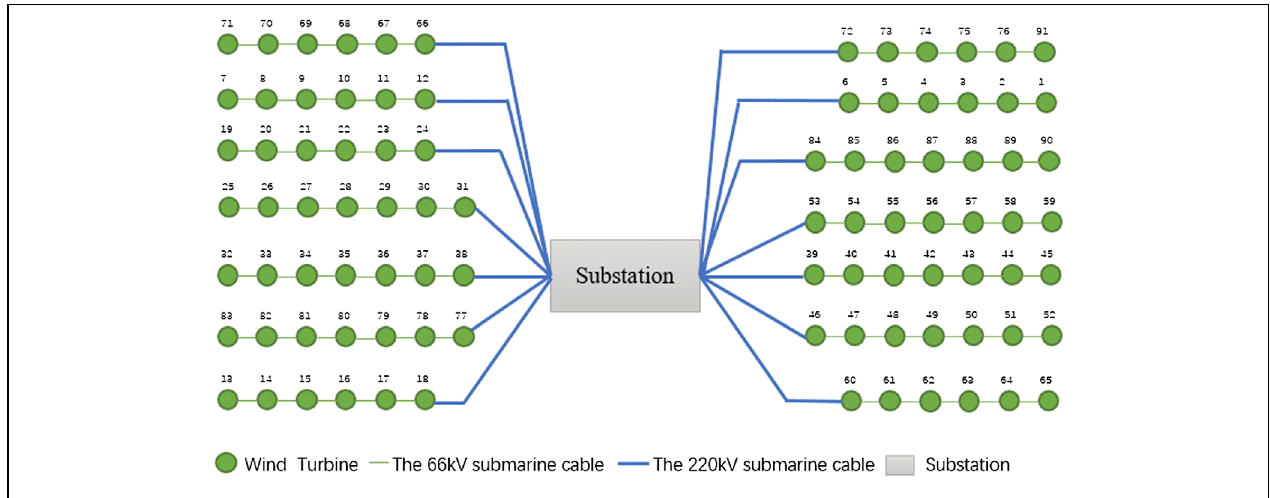
FIGURE 3 | Topology of the offshore wind farm system.